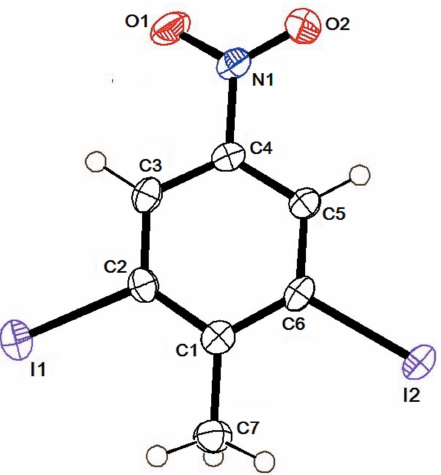
Figure 1 The molecular structure of DINT with the atom labelling and displacement ellipsoids drawn at the 50% probability level.